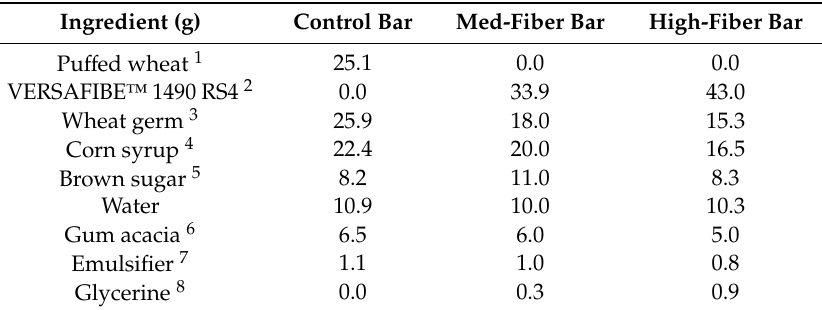
Table 2. Control and test (fiber) bars